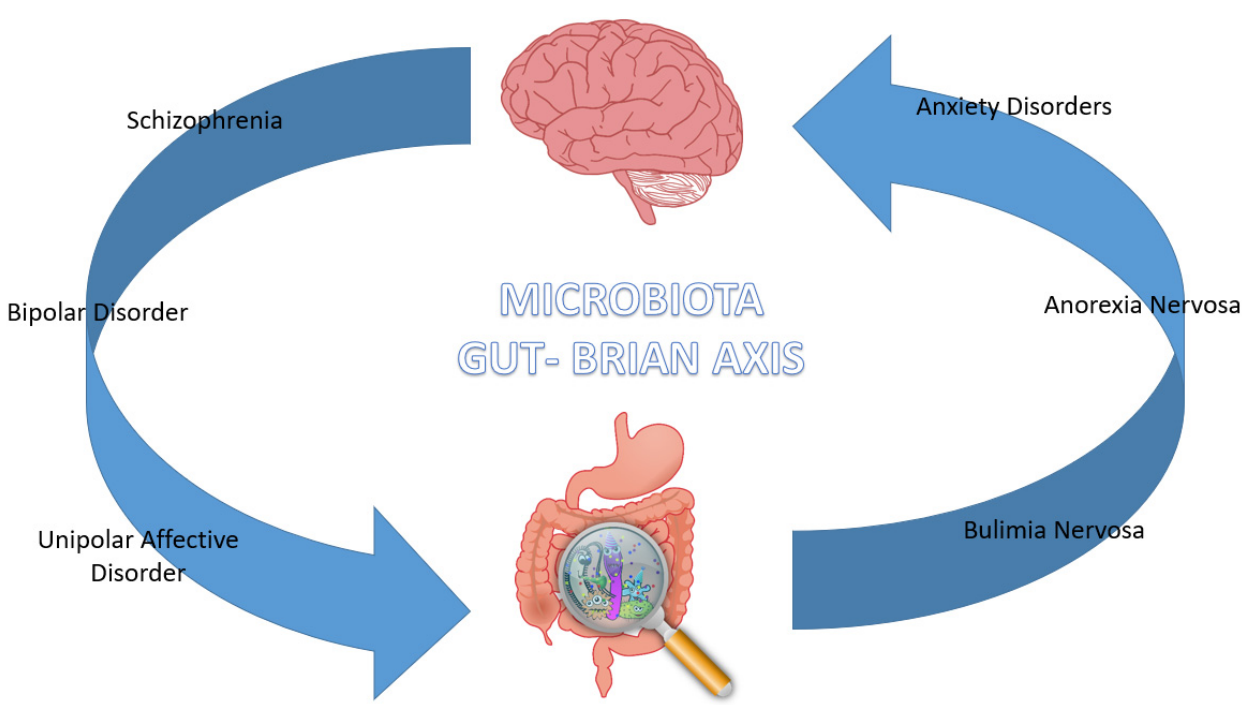
Figure 2. Microbiota–Gut–Brain axis involvement in Psychiatric Disorders.